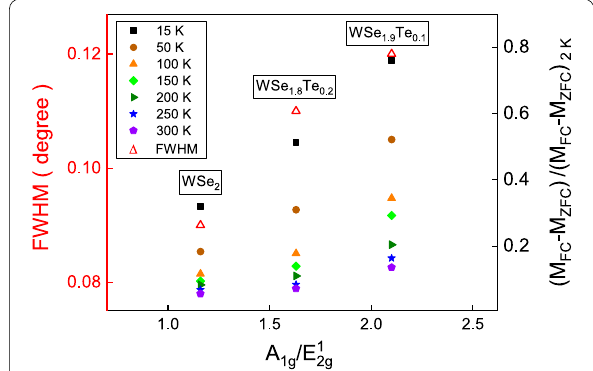
Fig. 5 The full width at half maximum (FWHM) of the X‑ray diffraction peak (002), and the normalized magnetic moment difference of field‑cooled (FC) and zero‑field‑cooled (ZFC) processes as a function of A 1g / E 1 2g . Both follow the same tendency and are positive in the A 1g / E 1 2g . Larger lattice dislocation leads to larger FWHM. These results imply the element replacement distorts the lattice and enhances intrinsic